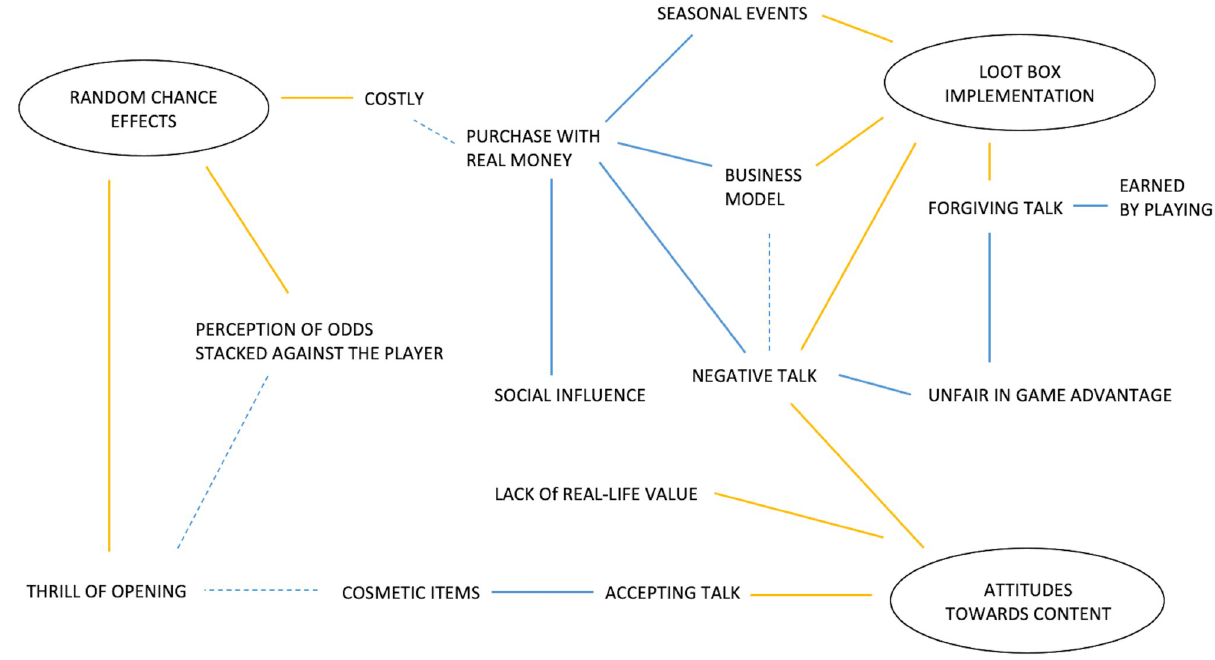
Fig 2. Thematic map of participant’s conceptualisations of loot